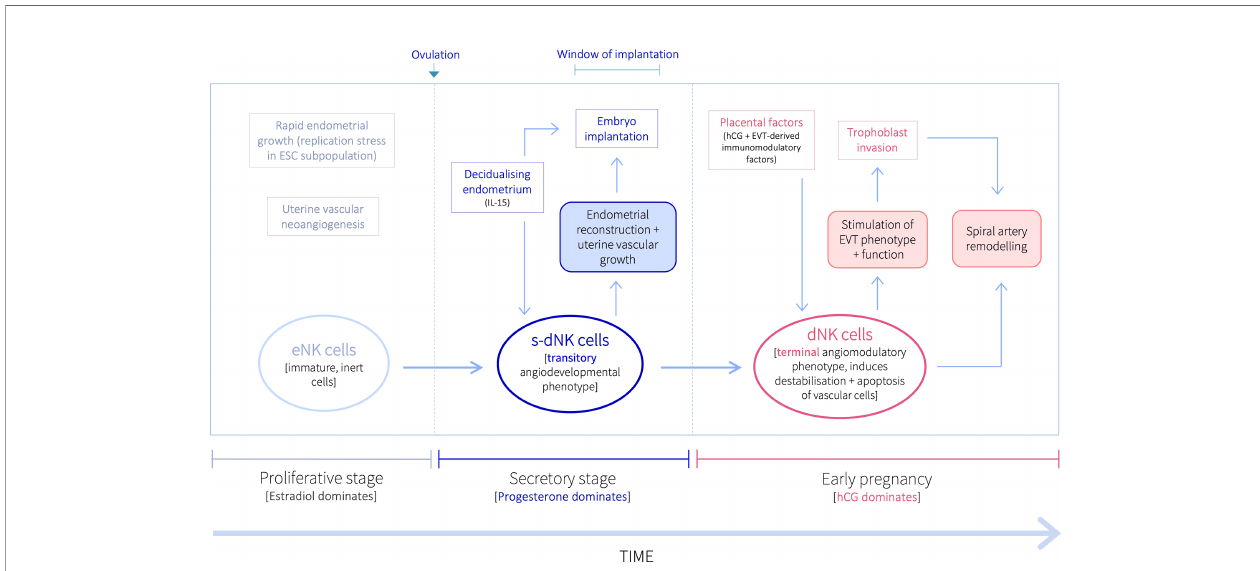
FIGURE 1 | Proposed temporal natural killer cell differentiation pathway within the uterine mucosa. Following ovulation, progesterone upregulates the production of IL-15 by ESCs in the secretory stage endometrium decidualisation progresses. IL-15 stimulates the proliferation, activation, and maturation of inert eNK cells into a transitory angiodevelopmental s-dNK phenotype that induces uterine vascular growth and mediates endometrial reconstruction to facilitate embryo implantation. Following implantation, placental-derived hCG drives further NK proliferation, and EVT-derived immunomodulatory factors promote their differentiation into a terminal angiomodulatory dNK phenotype, with destabilising and pro-apoptotic effects on vascular cells and pro-invasive effects on EVT, to initiate the uterine vascular changes crucial for successful pregnancy